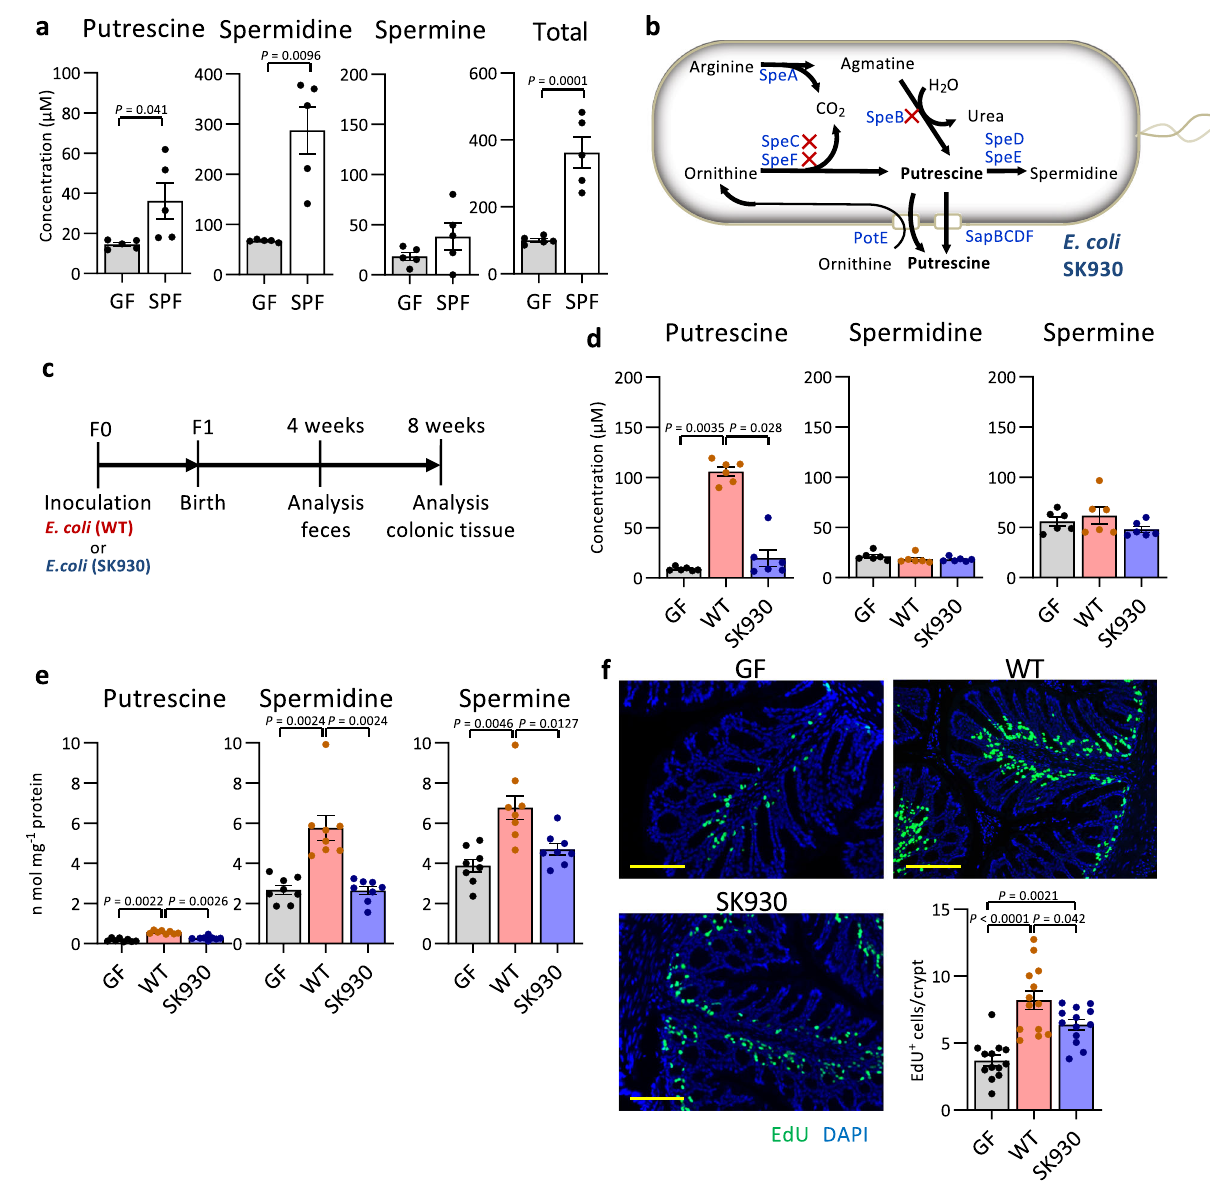
Fig. 1 Bacterial putrescine facilitates epithelial cell proliferation in the colon. a Polyamine concentrations in faeces of eight-weeks old GF and SPF mice ( n = 5). b Polyamine synthesis pathway in E. coli and the deleted genes (marked with X) in an E. coli strain SK930. Blue letters represent enzymes and transporters: arginine decarboxylase (SpeA), agmatine ureohydrolase (SpeB), ornithine decarboxylase (SpeC and SpeF), adenosylmethionine decarboxylase (SpeD), spermidine synthase (SpeE), putrescine-ornithine antiport transporter (PotE) and putrescine exporters (SapBCDF). c Experimental design for gnotobiotic mice colonised with WT or SK930 strain. d The polyamine concentrations in faeces of F1 mice. e The polyamine concentrations in CECs ( n = 8, independent animals). f Representative microscopic images of EdU assay and quanti fi cation of EdU-positive cells/crypt in each group. EdU- positive cells (green). Nuclei are counterstained with DAPI (blue) ( n = 8, independent animals). Scale bars: 100 µ m. Three randomly selected areas were examined per slide ( n = 13). All data shown represent the mean ± SEM. Statistical signi fi cance was calculated using a the Welch ’ s t -test (two-sided), d ,